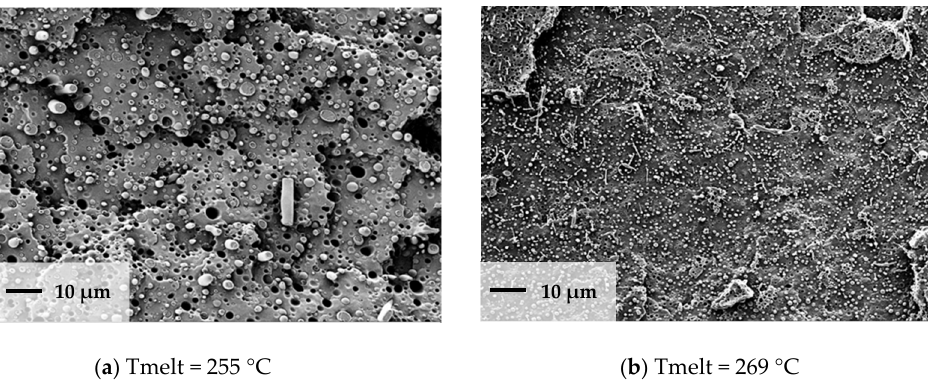
Figure 9. Morphology of PP 22 wt% PET blend: ( a ) melt temperature = 255 °C, ( b ) melt temperature = 269 °C.